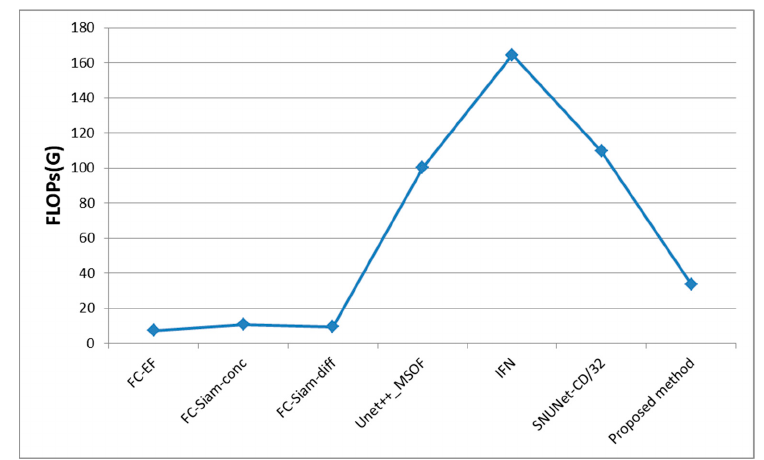
Figure 12. Comparison of the number of FLOPs for different methods.